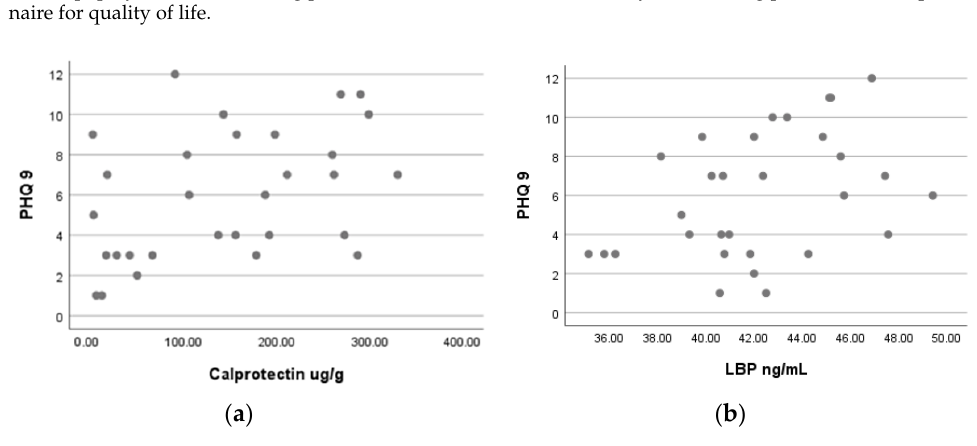
Figure 1. Spearman’s correlations between patients’ health score and biomarkers ( a ) calprotectin and ( b ) lipopolysaccharide-binding protein. ( b ) lipopolysaccharide-binding